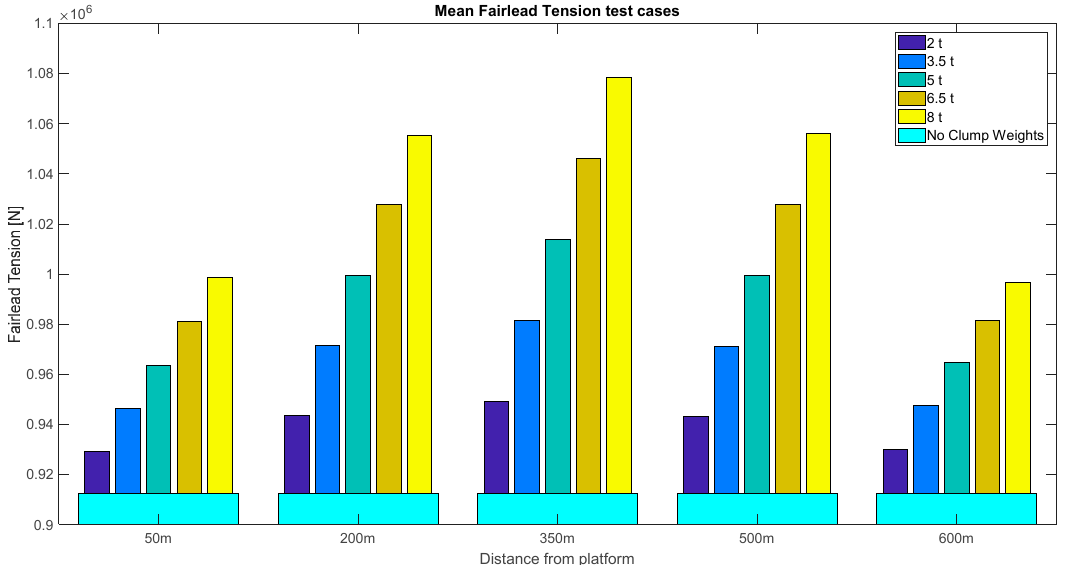
Figure 7. Fairlead mean tension as a function of the weight and the position of the cable ballast.